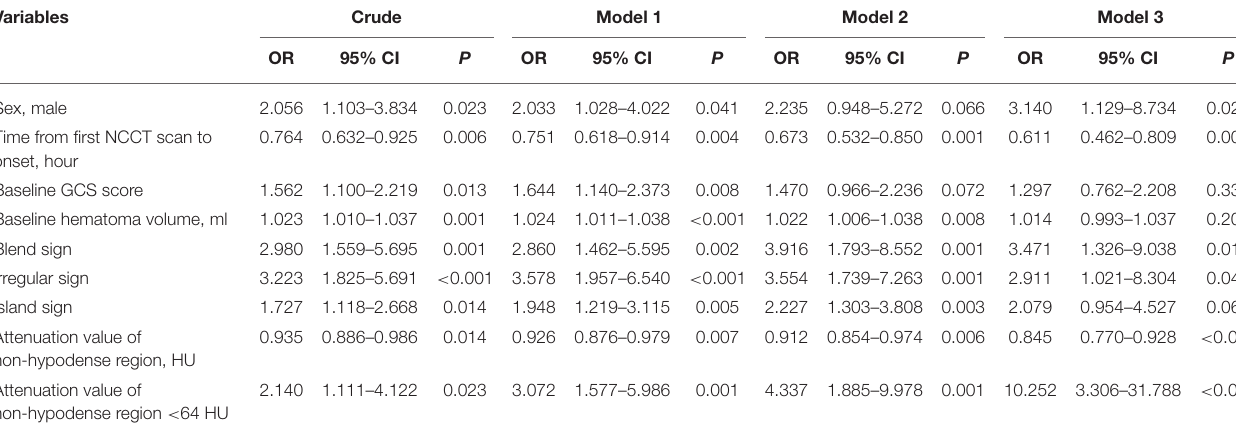
FIGURE 5 | Receiver operating characteristic (ROC) curves. (A) An ROC analysis for determining the critical attenuation value of the non-hypodense region of hematoma in the derivation cohort. (B) An ROC analysis of the attenuation value < 64 HU for predicting HE in the validation cohort. TABLE 2 | Variables with statistical significance for predicting HE analyzed by univariate logistic